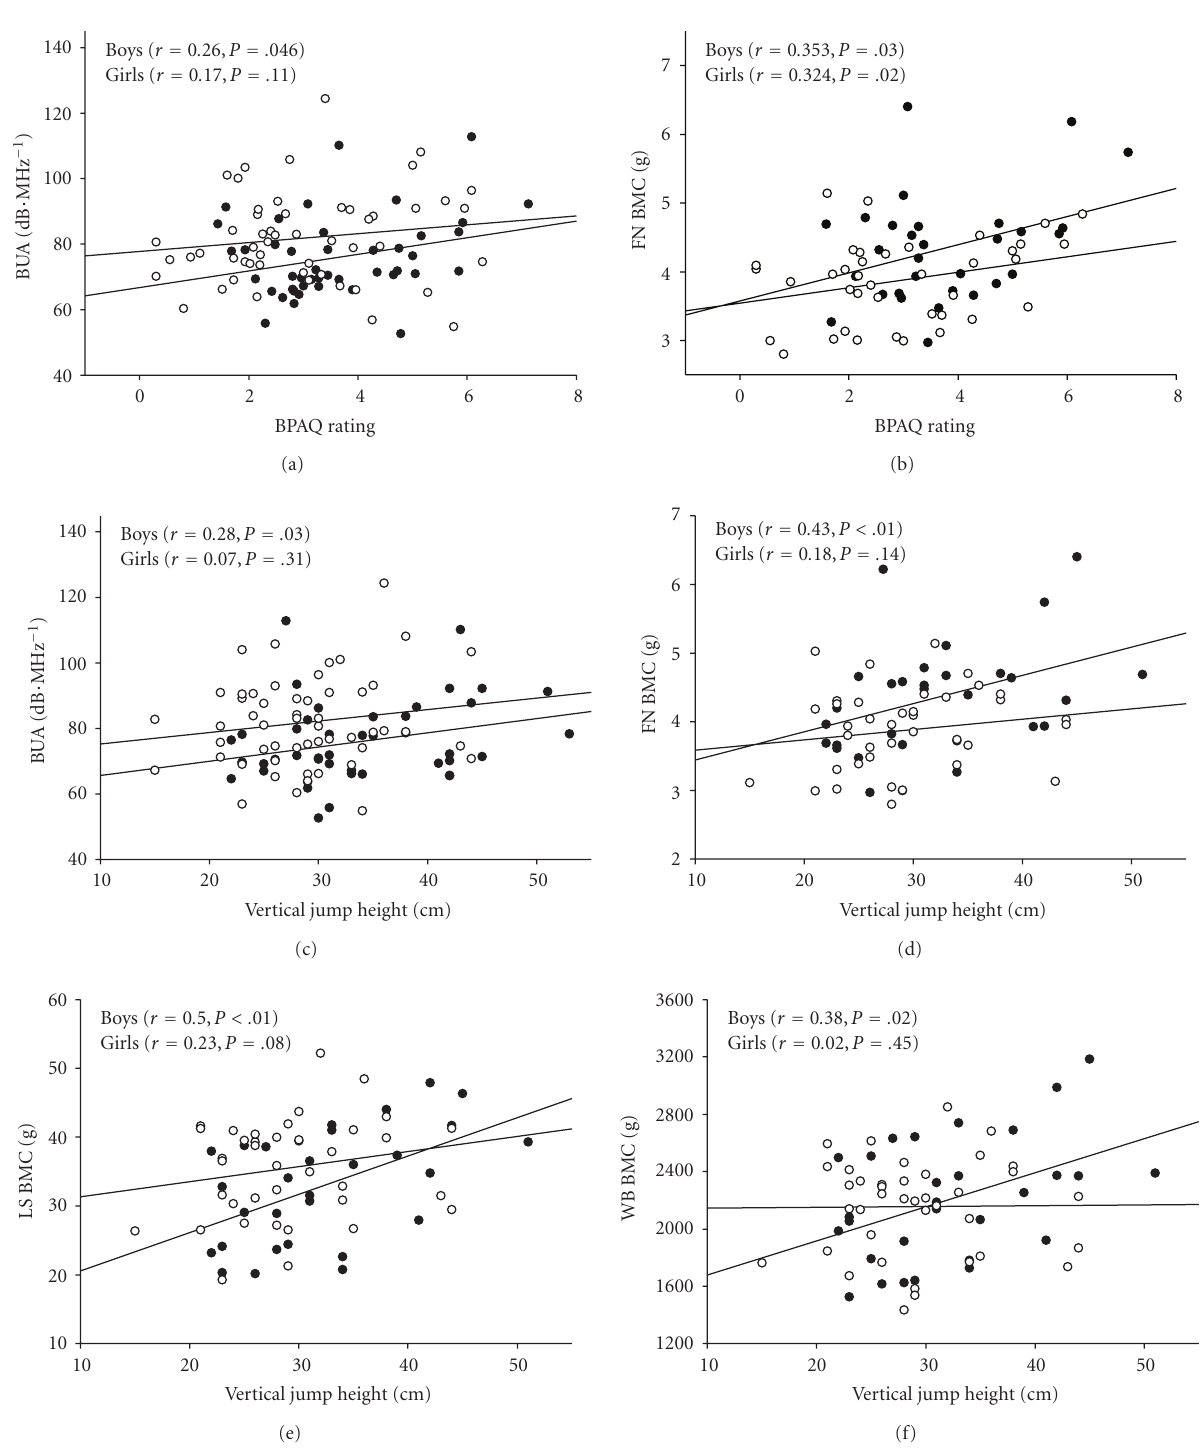
Figure 2: Correlation plots showing relationships between bone parameters and bone-specific physical activity questionnaire (BPAQ) score and vertical jump height for boys (closed circles) and girls (open circles). (a) BUA, broadband ultrasound attenuation; (b) FN BMC, femoral neck bone mineral content; (c) BUA, broadband ultrasound attenuation; (d) FN BMC, femoral neck bone mineral content; (e) LS BMC, lumbar spine bone mineral content; and (f) WB BMC, whole-body bone mineral